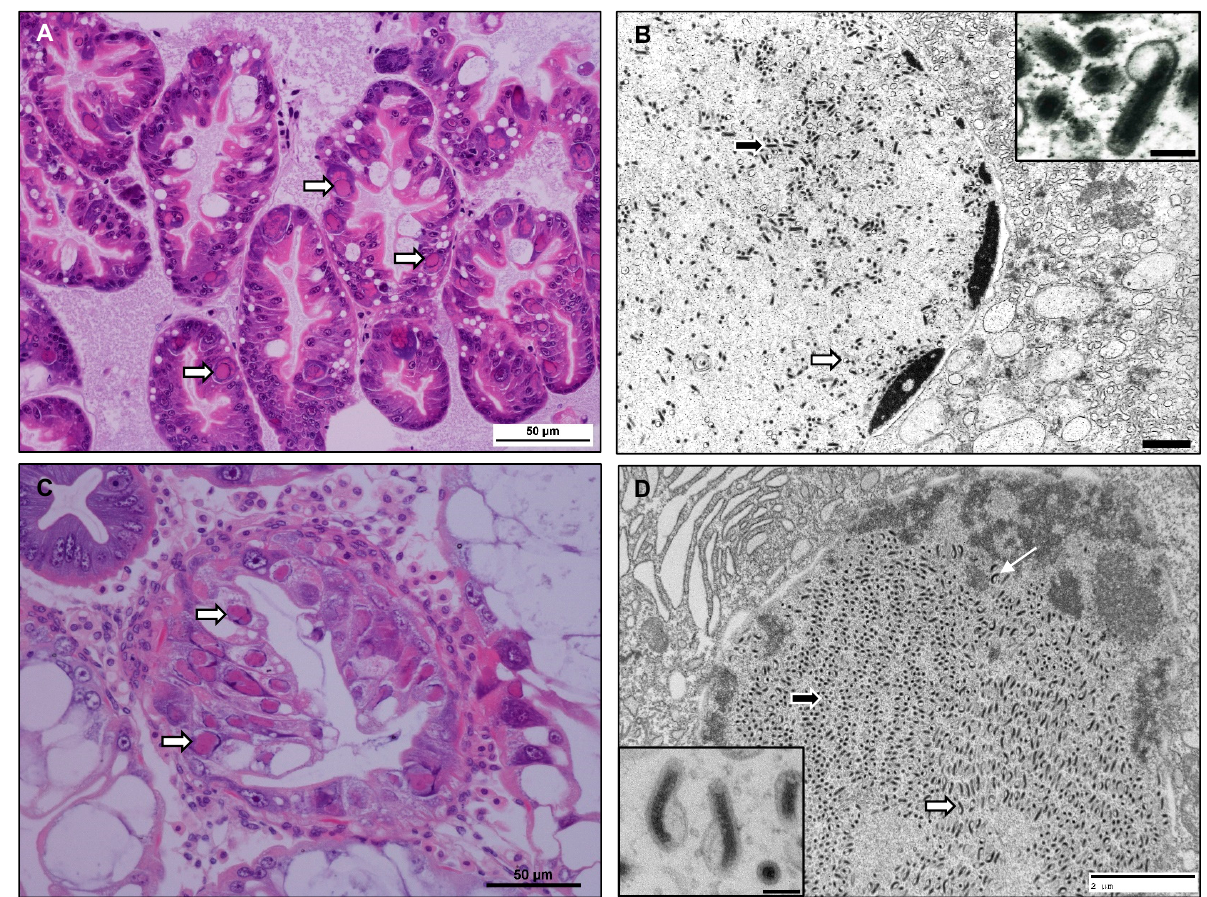
Figure 1. ( A ) Crangon crangon Nudivirus (CcNV) infected nuclei within hepatopancreas tubules. Infected nuclei (arrows) are enlarged with marginalised chromatin and contain an eosinophilic inclusion body. H&E stain. Scale bar = 50 µ m. ( B ) CcNV virions within an infected nucleus. Virions contain a rod shaped, electron dense nucleocapsid surrounded by a trilaminar envelope (inset, scale bar = 100 nm). Virions have been caught in cross section (black arrow) and longitudinal section (white arrow) within the nucleus. TEM. Scale bar = 1 µ m. ( C ) Carcinus maenas Nudivirus (CmNV) infected nuclei within hepatopancreas tubules. Infected nuclei (arrows) are enlarged with marginalised chromatin and contain an eosinophilic inclusion body. H&E stain. Scale bar = 50 µ m. ( D ) CmNV virions within an infected nucleus. Virions contain a rod shaped, electron dense nucleocapsid surrounded by a trilaminar envelope. Virions have been caught in cross section (black arrow) and longitudinal section (white arrow) within the nucleus. Some of the nucleocapsids appear curved (inset, scale bar = 100 nm) or u shaped (line arrow) within the envelope. TEM. Scale bar = 2 µ